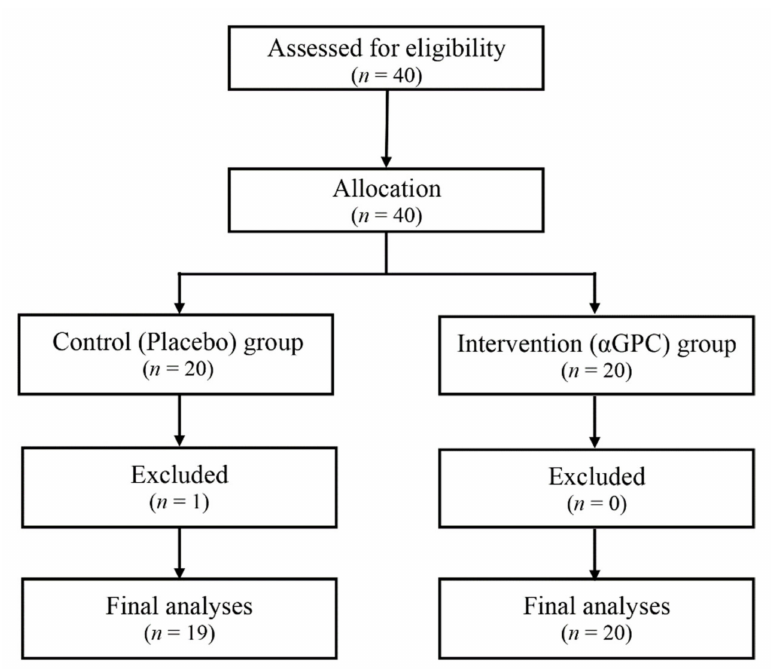
Figure 1. Flow diagram of patient recruitment in this